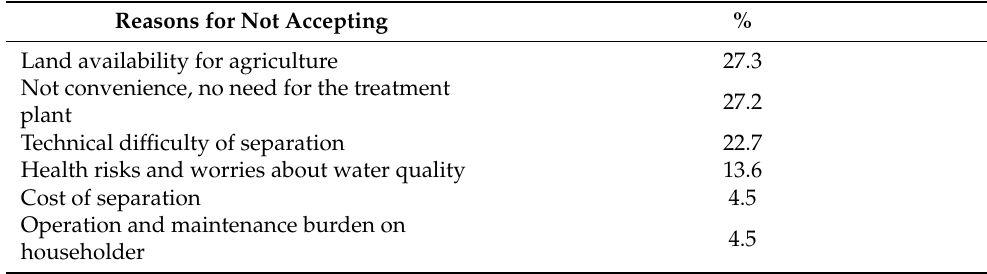
Table 2. Reasons for not acceptance of gray water